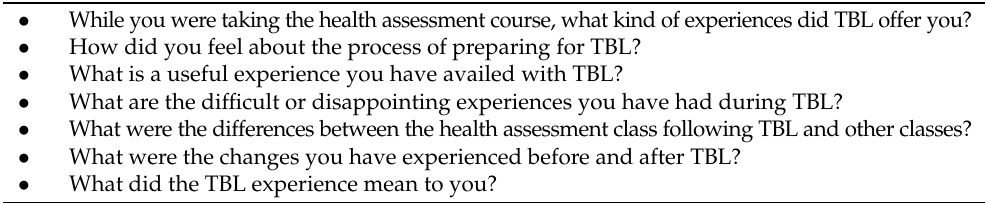
Table 2. Examples of key interview